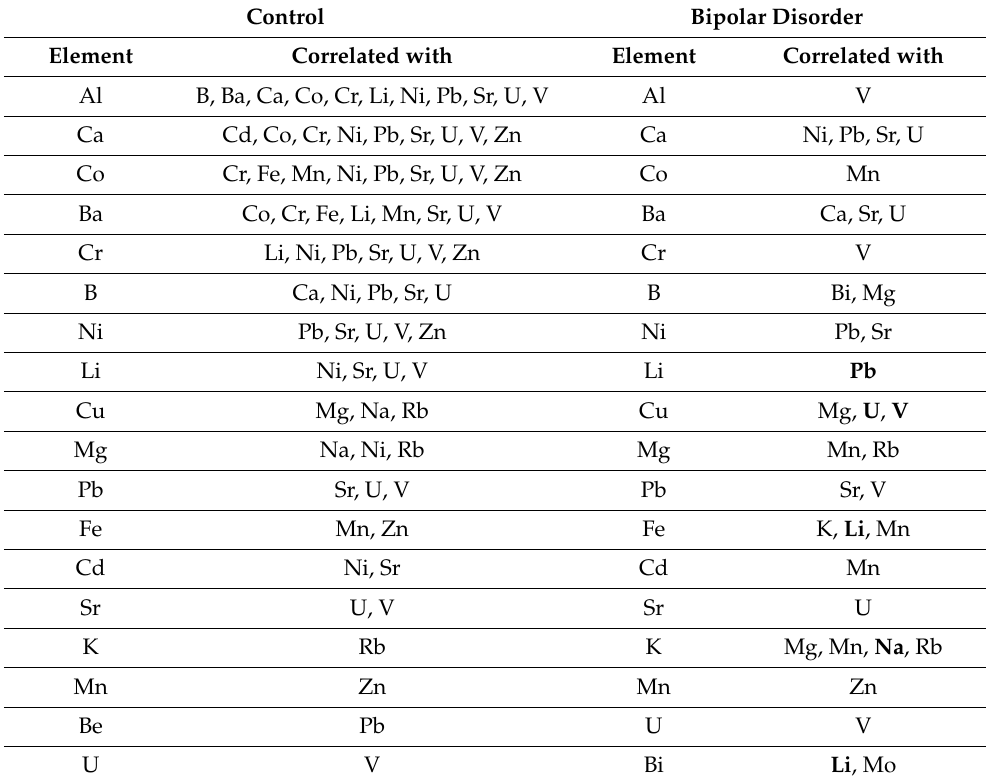
Table 7. Inter-elemental Spearman’s Rank significant correlations in PFC of control and bipolar disorder subjects. Control Bipolar Disorder Element Correlated with Element Correlated with Al B, Ba, Ca, Co, Cr, Li, Ni, Pb, Sr, U, V Al V Ca Cd, Co, Cr, Ni, Pb, Sr, U, V, Zn Ca Ni, Pb, Sr,